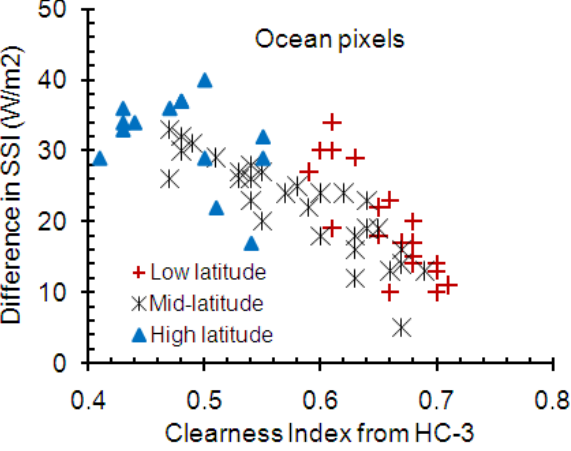
Figure 4. Difference in the 23-month means of SSI between HC-3 and HC-1 for ocean pixels; ordered in three classes: Low latitude: [−20°, 20°]; Mid-latitude: [−45°, 25°] and [25°, 45°]; High latitude: less than −50° and greater than 50°.